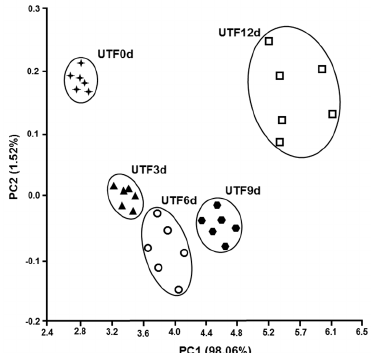
Figure 4. The principal components analysis (PCA) plot of the scores produced by the 10 sensor responses to the headspace of uncoated trout fillets (UTF) along the first two principal components. The number in parentheses indicates the proportion of the total variance explained by each principal component. The abbreviations near the clusters are UTF0d = uncoated trout fillet day 0 of storage; UTF3d = uncoated trout fillet day 3 of storage; UTF6d = uncoated trout fillet day 6 of storage; UTF9d = uncoated trout fillet day 9 of storage; UTF12d = uncoated trout fillet 12 days of storage. Results are representative of three trout analyzed for each experimental